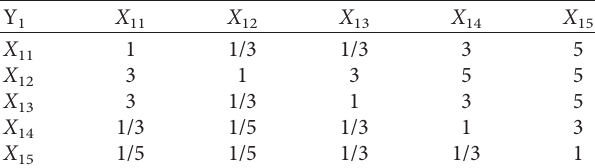
Table 5: Judgment matrix of the design